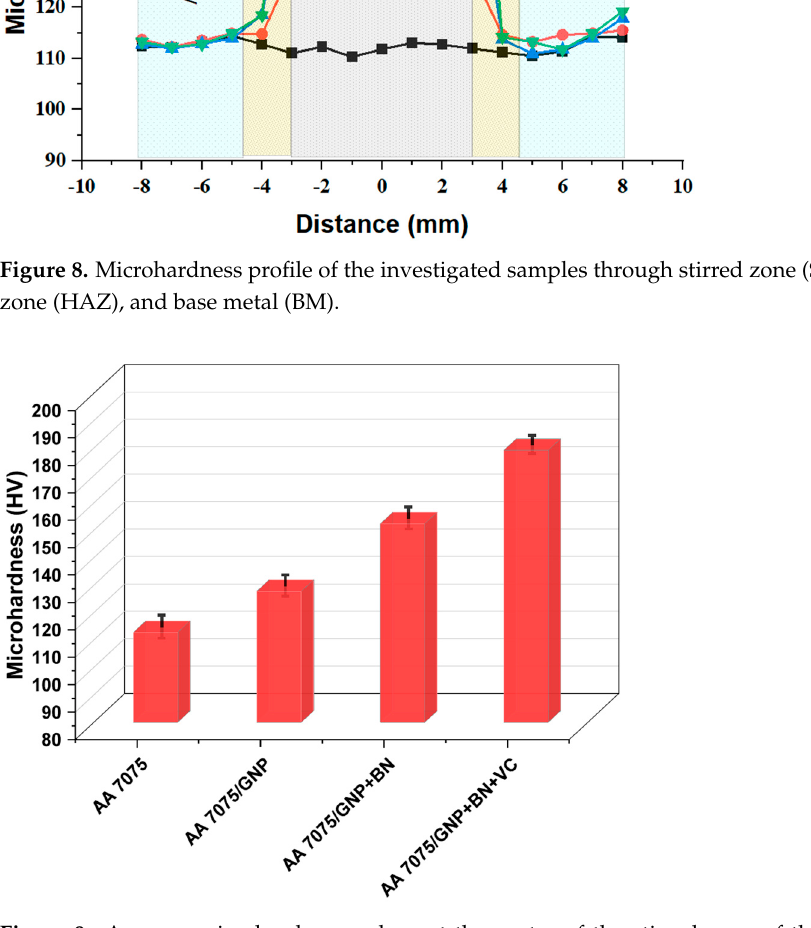
Figure 9. Average microhardness values at the center of the stirred zone of the different metal matrix composites.